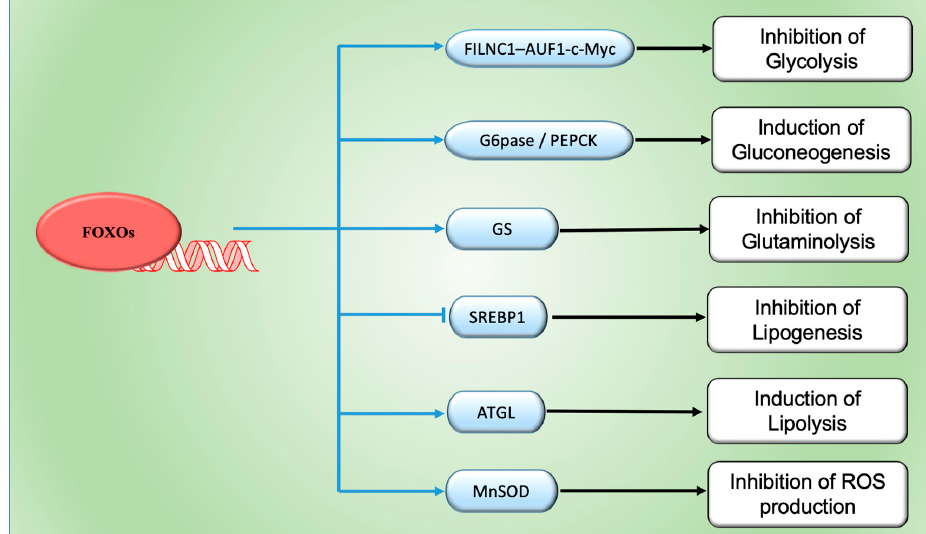
Figure 2. FOXOs regulate the transcription of a wide range of genes involved in tumor cell metabolism through inhibiting glycolysis, glutaminolysis, lipogenesis, and ROS production, as well as promoting gluconeogenesis and lipolysis. However, the precise roles of FOXOs in the regulation of cancer metabolism are only partially understood.